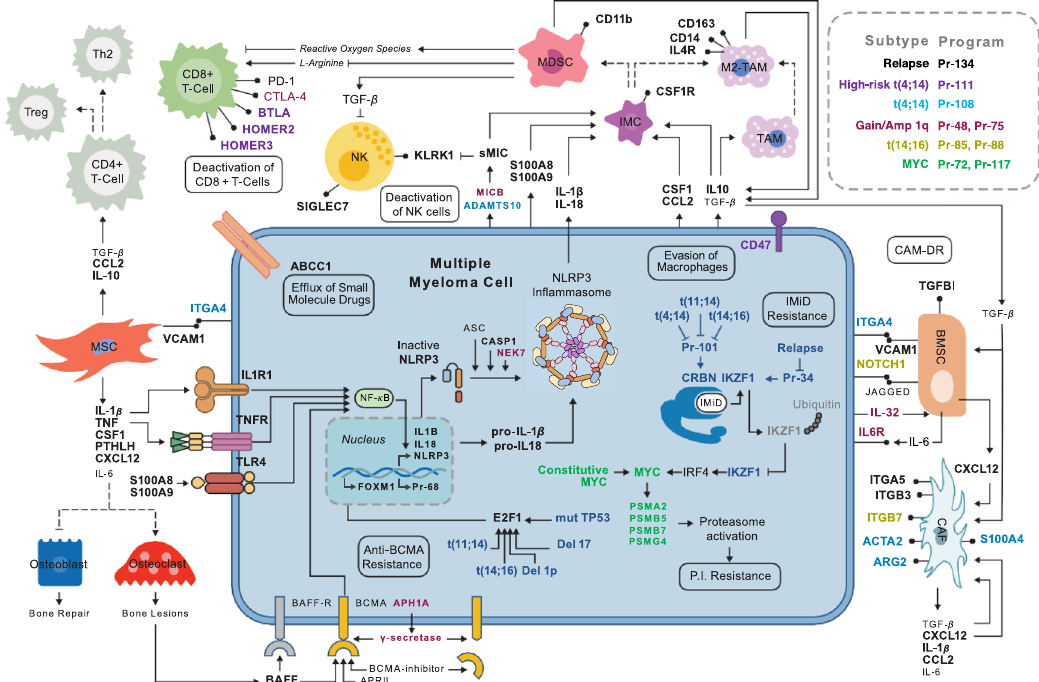
Fig. 7 Pr-134 schematic. The genes of Pr-134 include markers of cell types characteristic to the bone marrow (BM) microenvironment, NF- κ B signaling, and the NLRP3 in fl ammasome. The high activity of these genes at relapse suggests the engagement of the BM microenvironment to facilitate escape from therapy and evasion of immune cell-mediated killing. The high-risk clinical subtypes are complementary to Pr-134 in escaping therapy and immune surveillance and they promote the proliferation of multiple myeloma cells by activating Pr-68 via E2F1 and FOXM1 . Bold gene names indicate that the gene is present in the program of the corresponding color (see